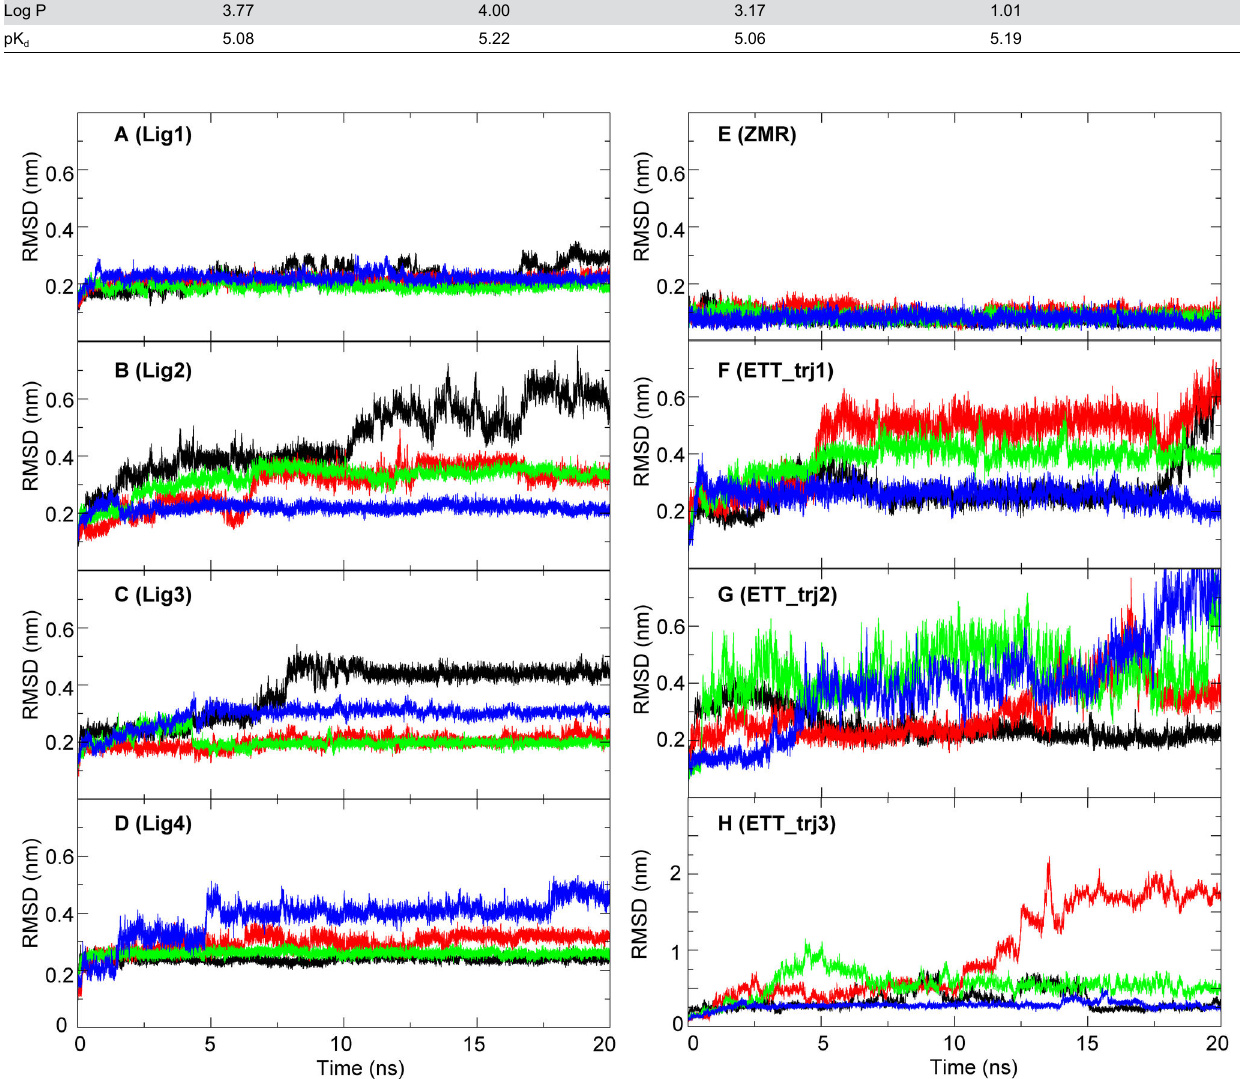
Figure 7. Root Mean Squared Deviation (RMSD) of ligands in different systems. RMSD values of the linked ligands as well as ZMR and ETT bound with 09N1 are shown in panel A-H. Lines colored in black, red, green and blue represented RMSD of protomer A-D in each complex